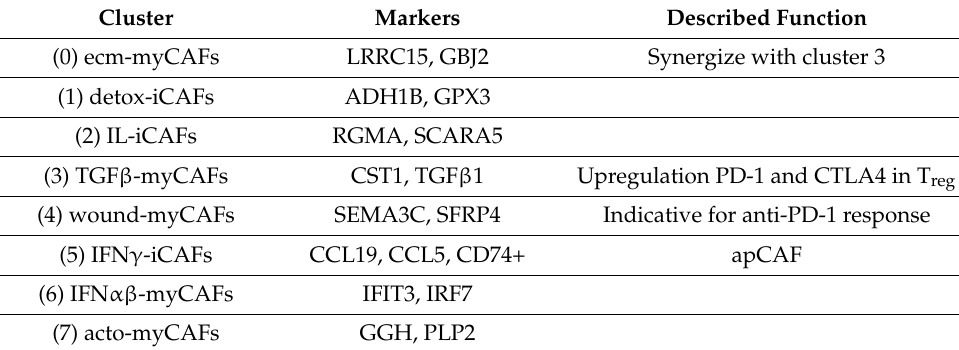
Table 2. CAF-S1 clusters that are described by the expression of different marker proteins and hence yield different tumor-modulating functions